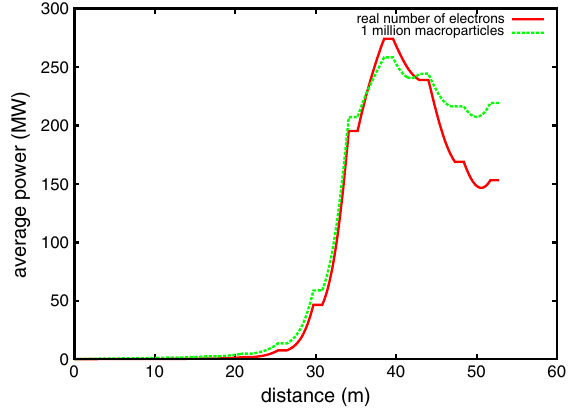
FIG. 15. Evolution of the average 1 nm x-ray radiation power inside the second undulator section of the self-seeded FEL beam line with the real number of electrons (red) and the one million macroparticle simulations